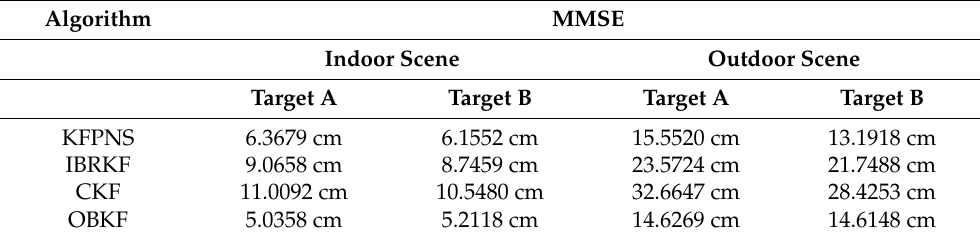
Figure 11. The RMSE of various Kalman filtering methods in different scenes. ( a ) The RMSE of the four Kalman filtering methods in an indoor scene with respect to target A and target B, respectively. ( b ) The RMSE of the four Kalman filtering methods in an outdoor scene with respect to target A and target B, respectively.